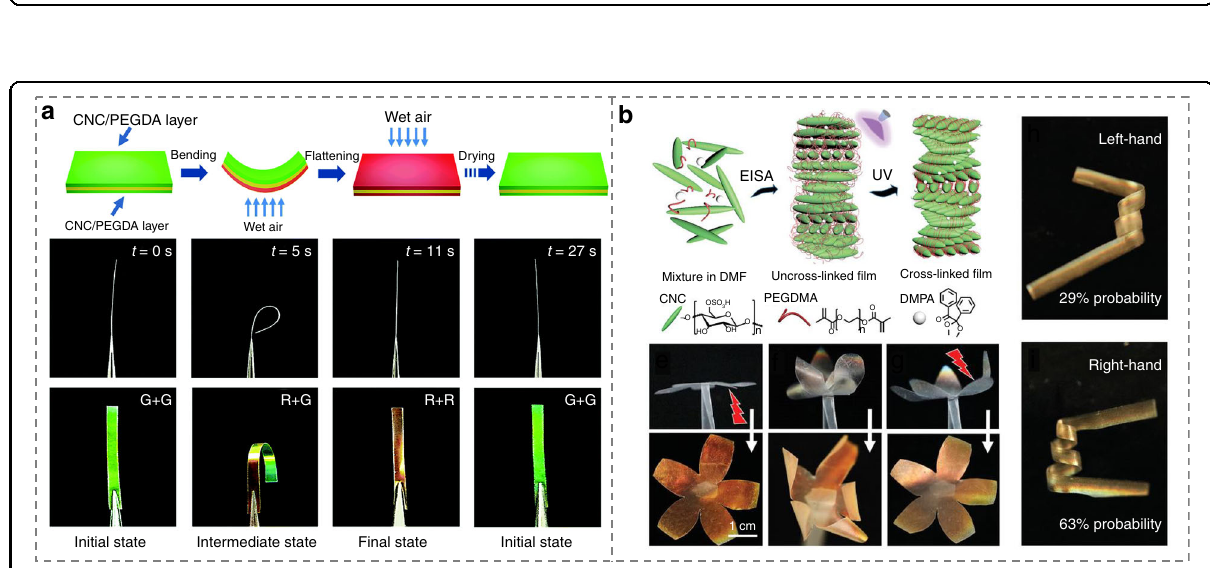
Fig. 15 bio-based LC soft actuators. a Deformation and color change of sandwich CNC fi lm driven by humidity 275 . Reproduced from ref. 275 , with permission from The Royal Society of Chemistry. b Moisture-driven actuation and complex deformation behaviors of the CNC-poly(ethylene glycol) dimethacrylate composite 42 . Reproduced from ref. 42 , with permission from